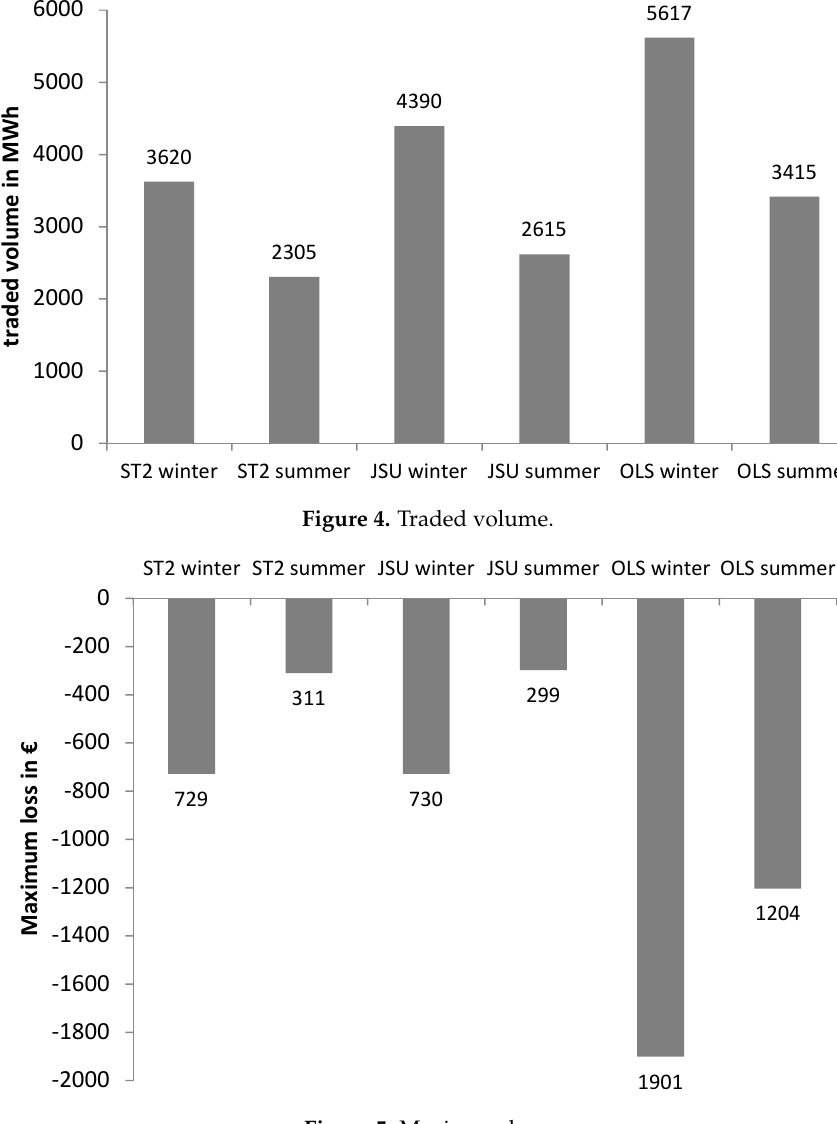
Figure 5. Maximum Figure 5. Maximum loss.